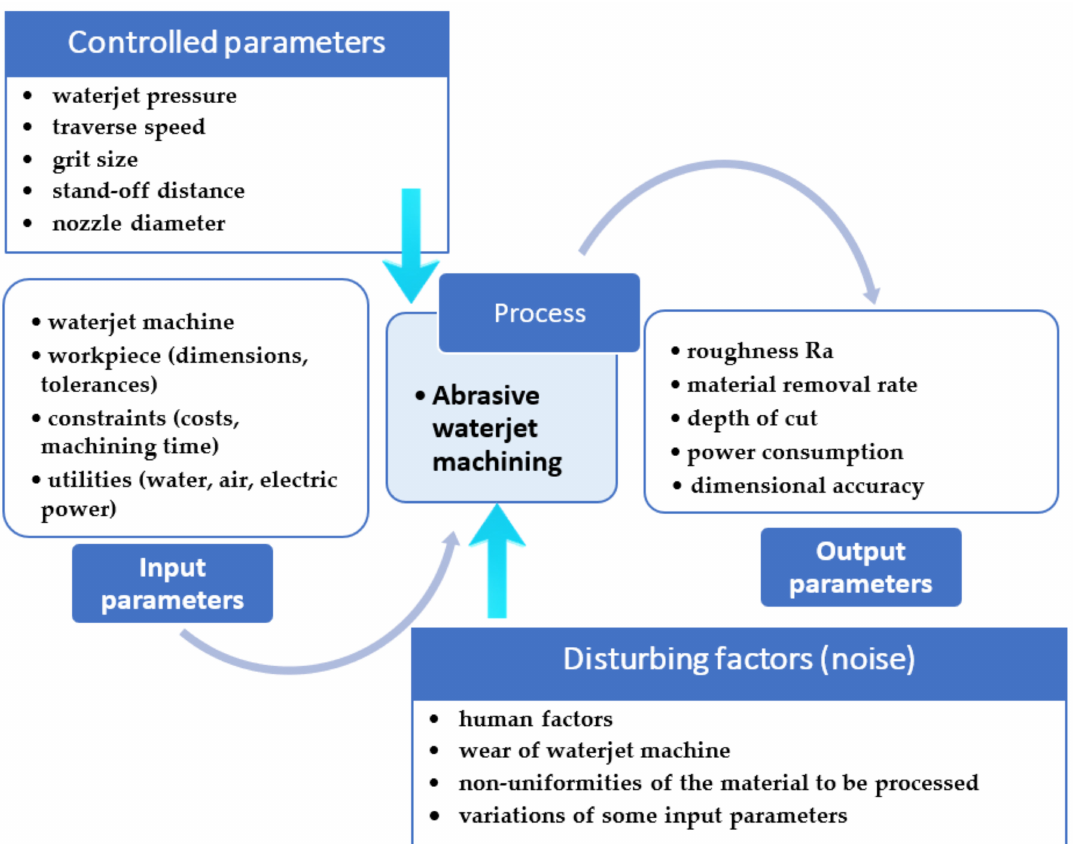
Figure 1. AWJM parametric